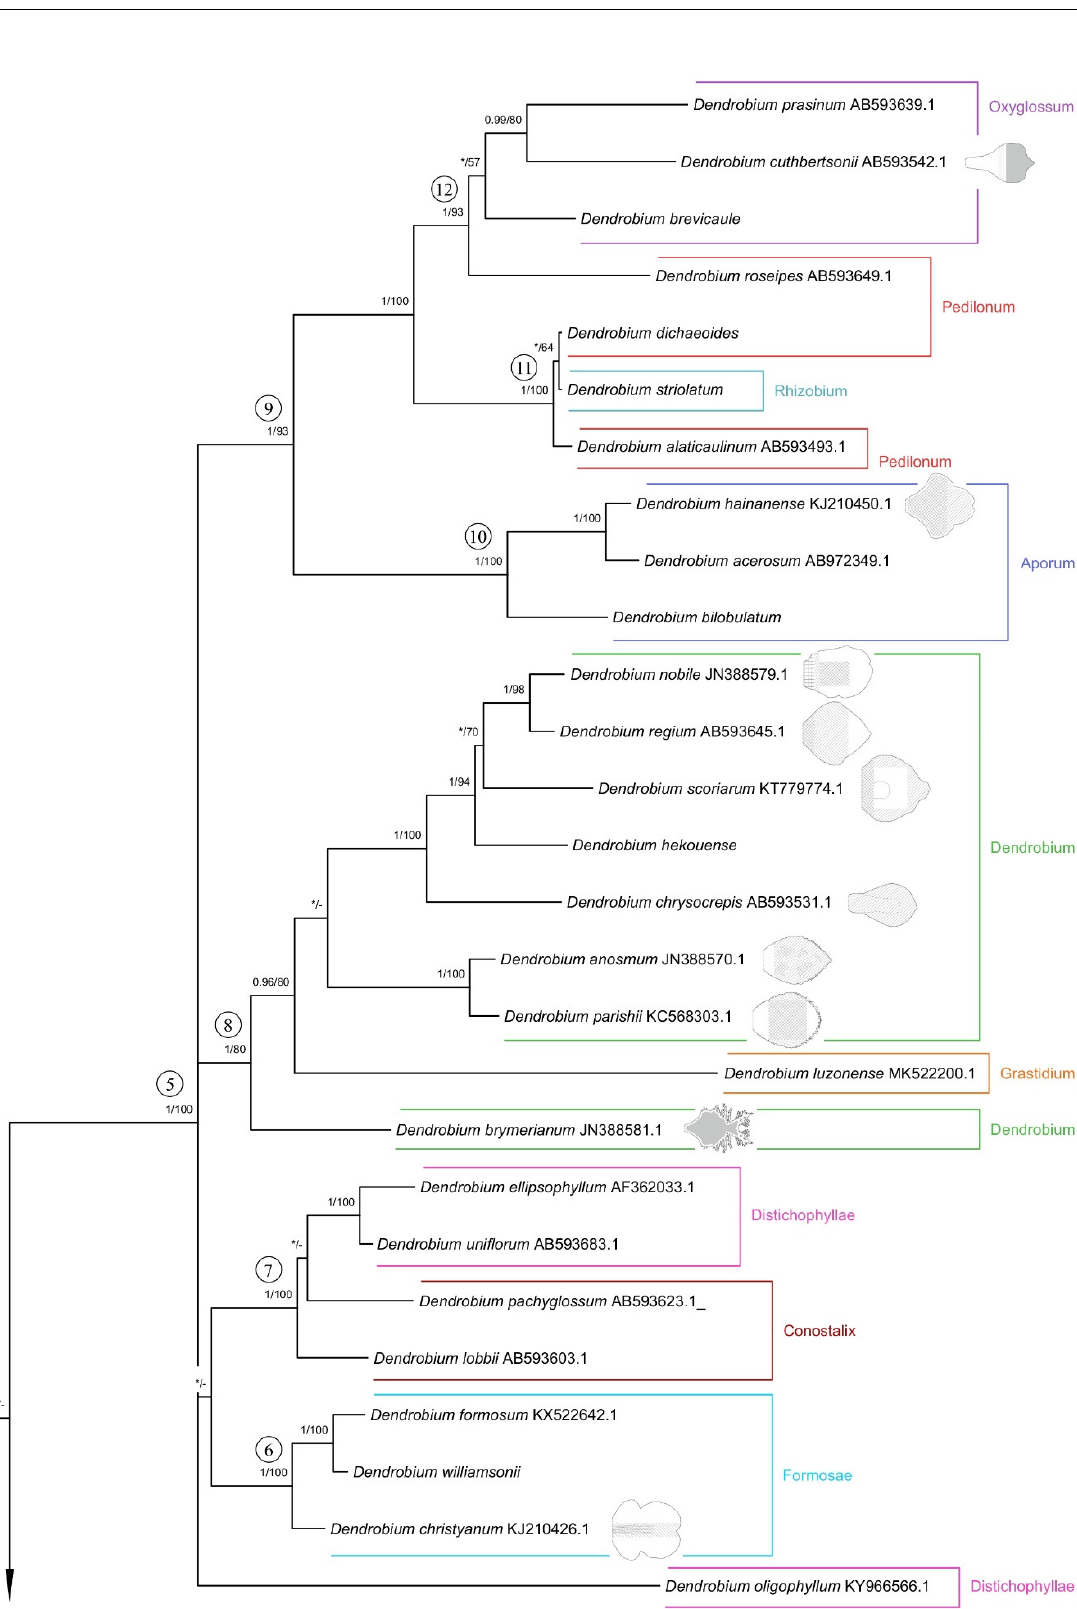
Figure 26. The 50% majority-rule consensus tree from the BI analysis of ITS marker. The numbers above the branches indicate posterior probability (PP) and bootstrap support (BS); PP < 0.95 were marked as an * and BS values of <50% were marked as -. Numbered black circles mark clades discussed in the